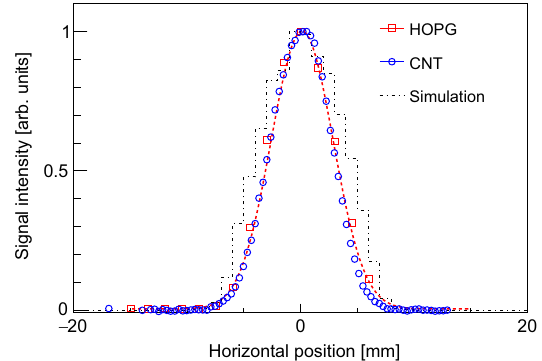
FIG. 6. Horizontal distributions measured with HOPG-BSM and WSM using the CNT wire. The size of the HOPG target was 0 . 2 ð width Þ × 1 . 0 ð thickness Þ mm 2 . The red-dotted line indicates a fitted function. Distribution simulated with PARMILA code is also shown.